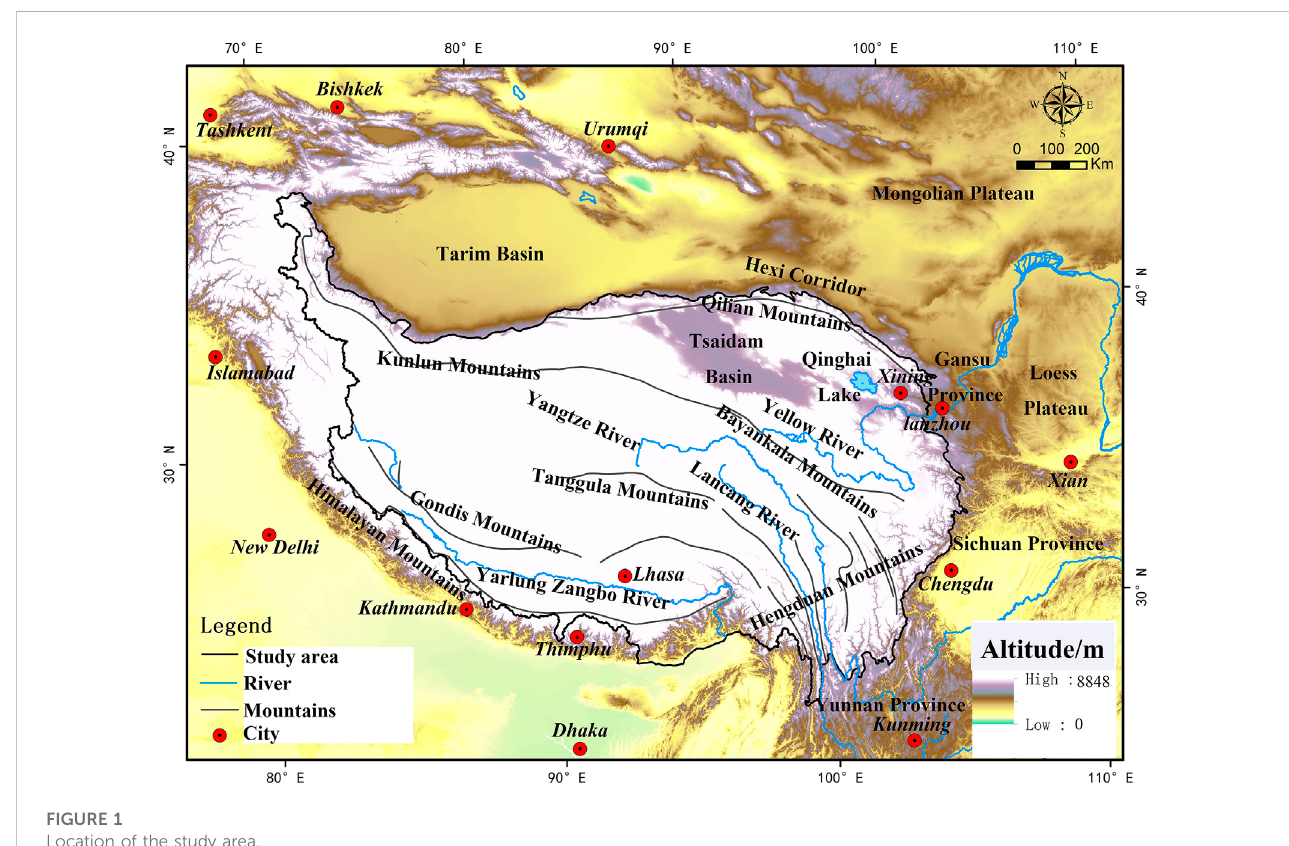
FIGURE 1 Location of the study